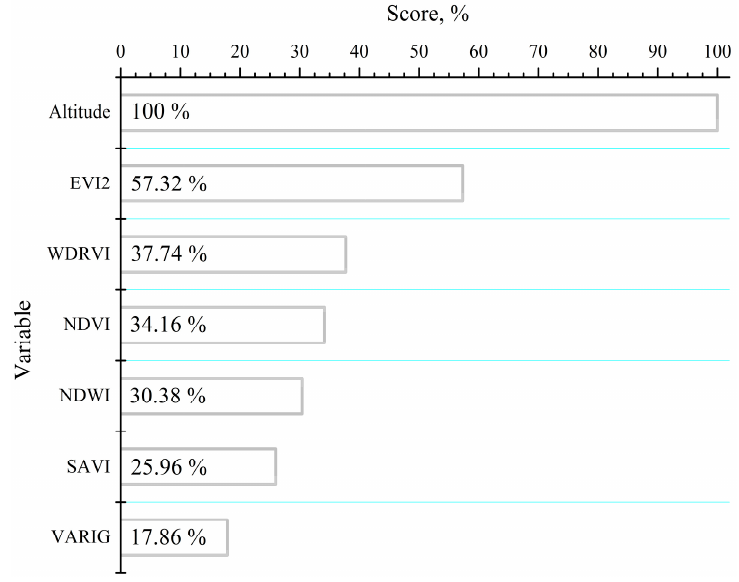
Figure 5. The importance of the variables assessed suing mean decrease in OOB accuracy.